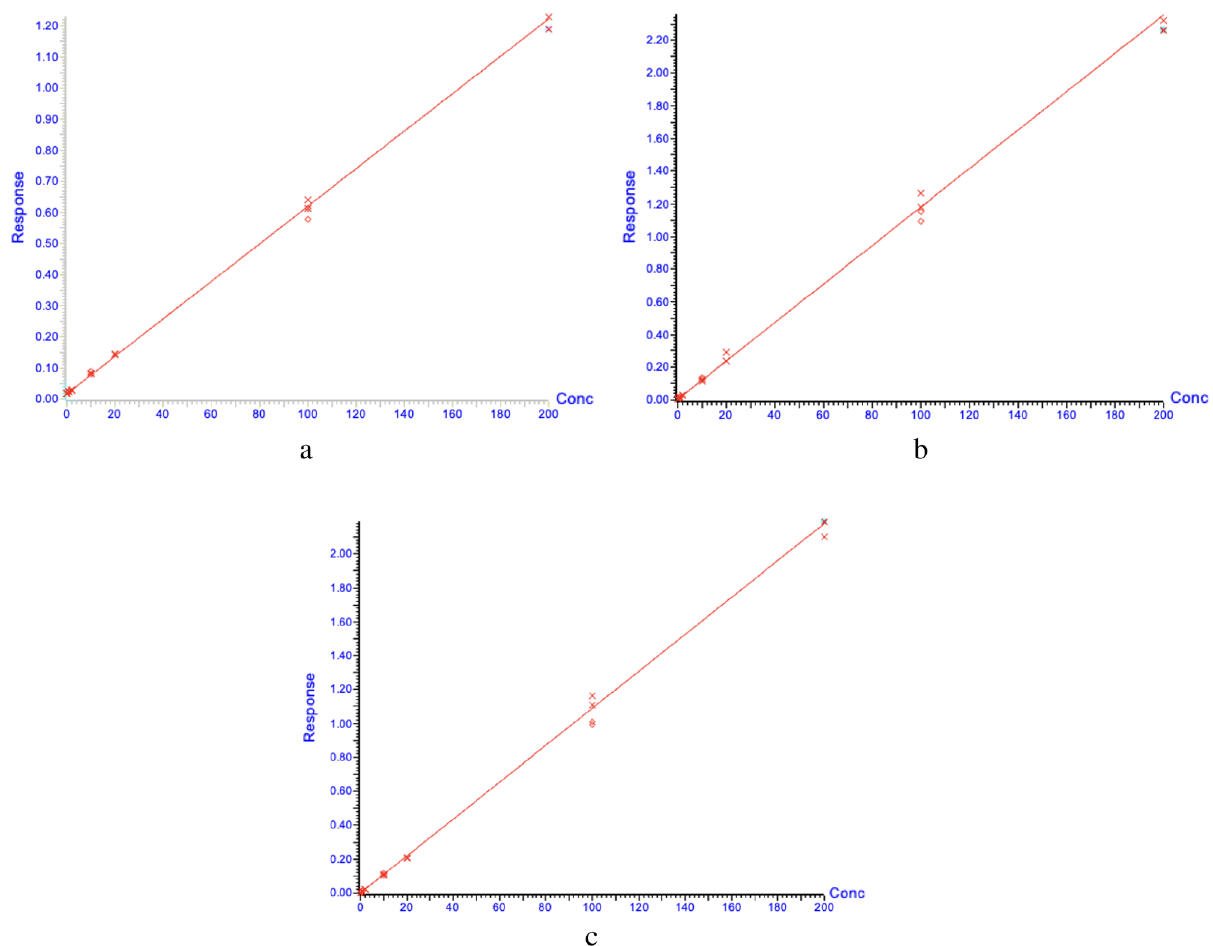
Figure 5. Concentration–response calibration curves for ( a ) tamoxifen (TAM), ( b ) Z-endoxifen (END), and ( c ) 4-hydroxytamoxifen (4HT). Calibration curve linearity was r = 0.999 and r 2 = 0.999 for TAM, r = 0.999 and r 2 = 0.997 for END, and r = 0.999 and r 2 = 0.999 for